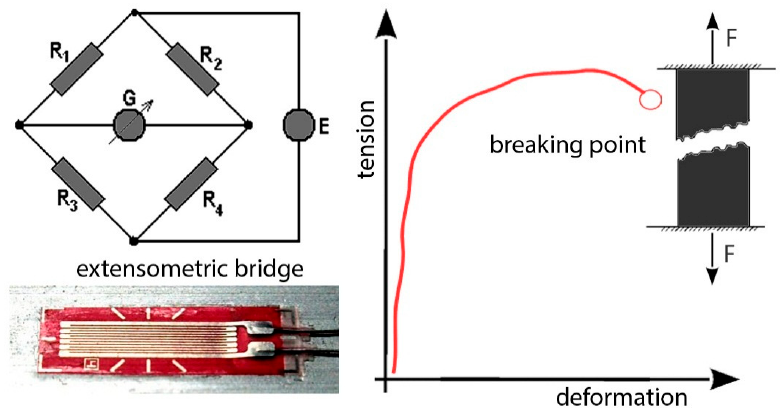
Figure 13. Low ‐ intensity tensil test measures required for the calibration of the extensometric sensor. All measurements must be taken with extensometric bridge to avoid data fluctuation.